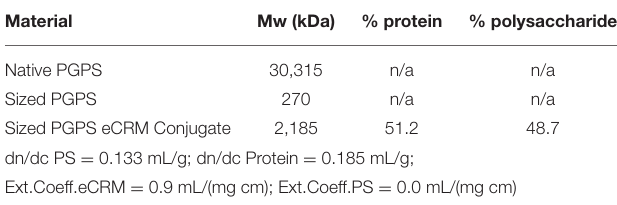
TABLE 1 | SEC-MALS Mwt